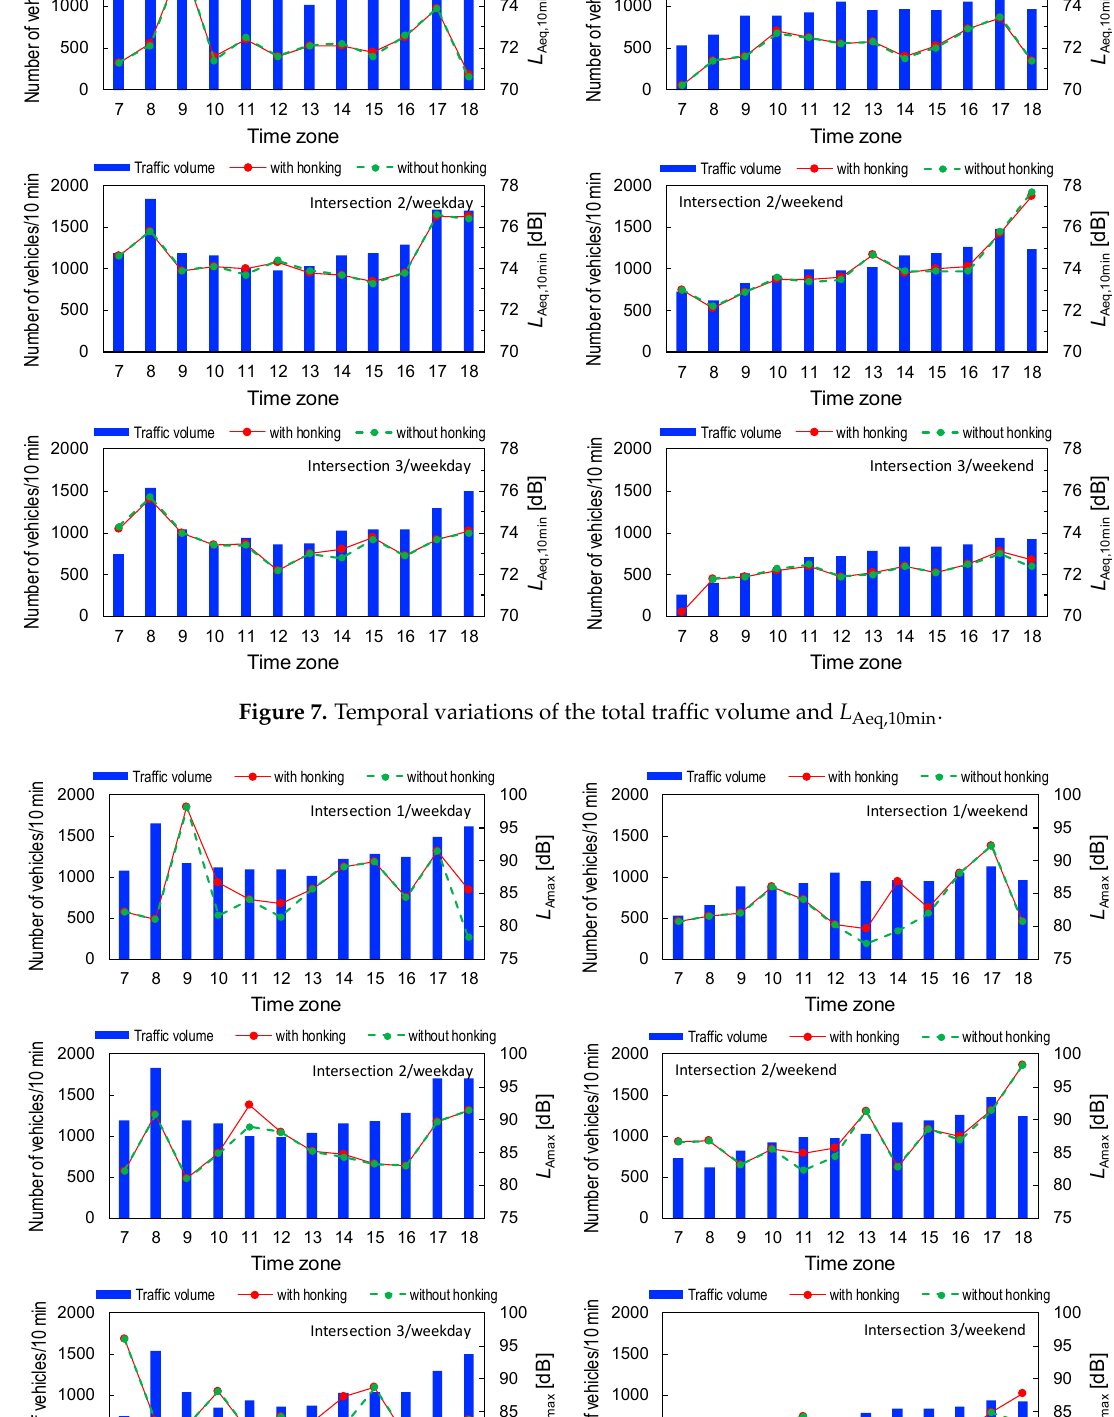
Figure 8. Temporal variations of the total traffic volume and L Amax .